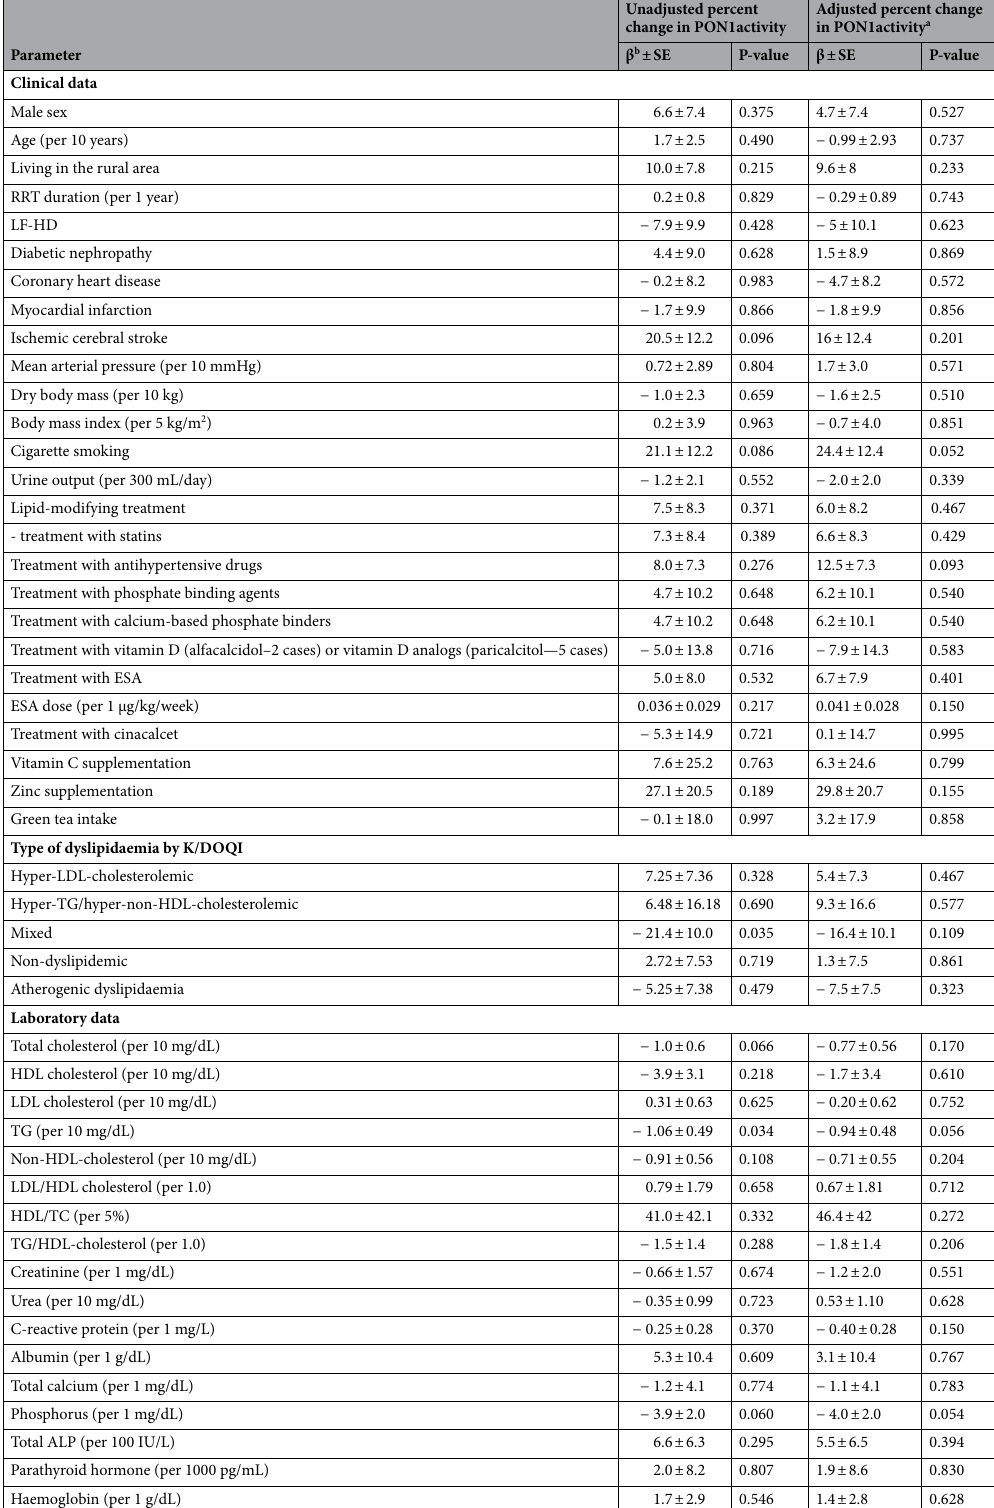
Table 6. Correlates of serum PON1 activity (U/L) in HD patients (n = 93). ALP alkaline phosphatase, ESA erythropoietin-stimulating agent, HD haemodialysis, HDL high-density lipoprotein, LDL low density lipoprotein, LF-HD low-flux haemodialysis, PON1 paraoxonase 1 gene, RRT renal replacement therapy, TG triglycerides. a Gender, cigarette smoking, urine output, living in a rural area, and serum phosphorus were used for adjustment in the multiple regression analysis. b β coefficient can be interpreted as the percent change expected in serum PON1activity for each unit change in the tested